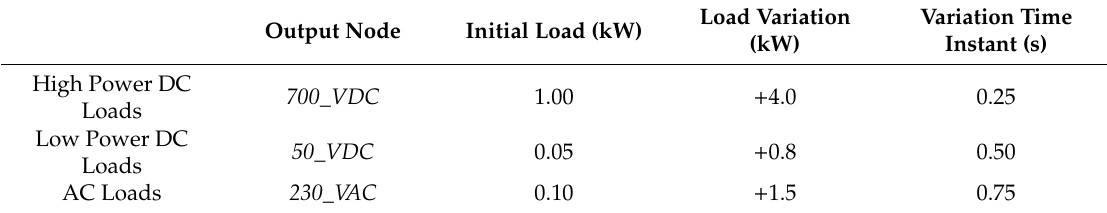
Figure 7. Voltage response to load variations, considering the point of delivery (PoD) and all the proposed architecture output nodes: ( a ) Step power variation; ( b ) Ramp power variation (ramp time 0.05 s). Table 3. Load power and connection time.